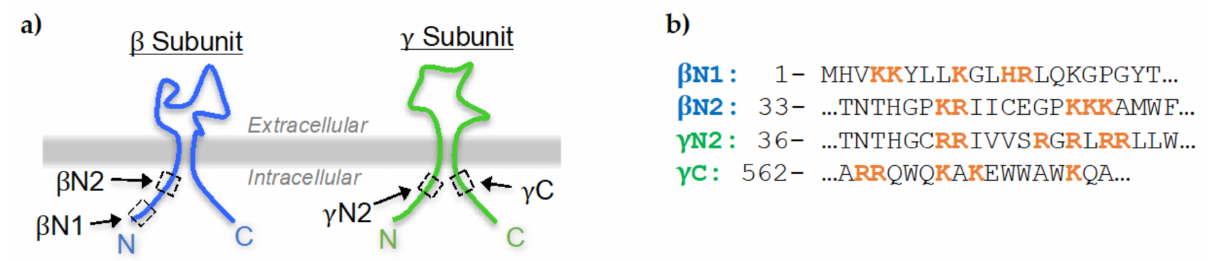
Figure 1. Cationic sites in ENaC tested for PIP2 binding. ( a ) Schematic of the ENaC subunits with the sites tested for PIP2 binding, β N1, γ N2, γ C, and β N2, indicated by dashed boxes. Adapted from Archer et al., 2020 [13]. ( b ) Human ENaC sequences corresponding to β N1, γ N2, γ C, and β N2. The cationic residues neutralized to alanine are indicated in boldface orange